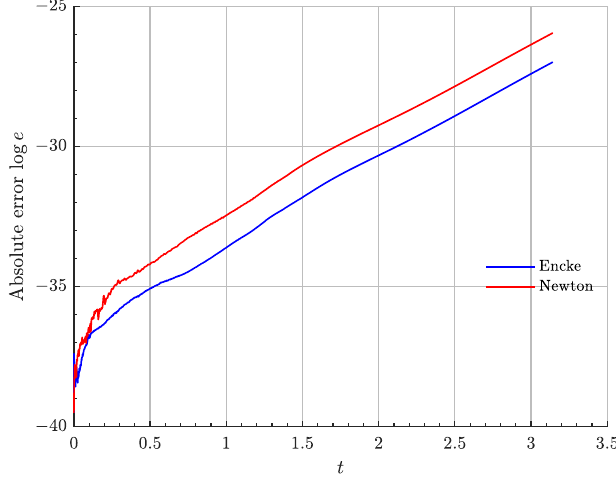
Figure 2. Integration error for the different relative dynamics